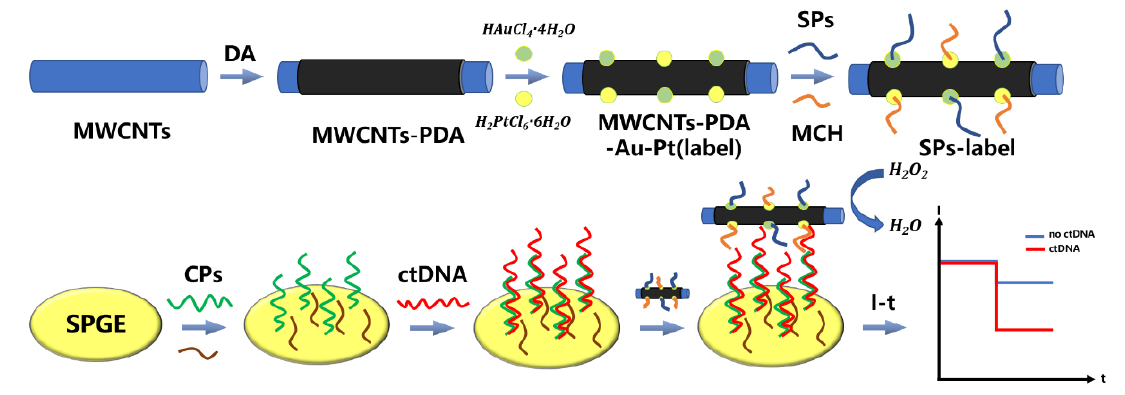
Figure 4. Schematic diagram of sandwich structure ctDNA electrochemical biosensor based on MWCNTs–PDA–Au–Pt nanocomposite and SPs-label (Adapted with permission from Ref. [41]. 2021, Zhao et al).